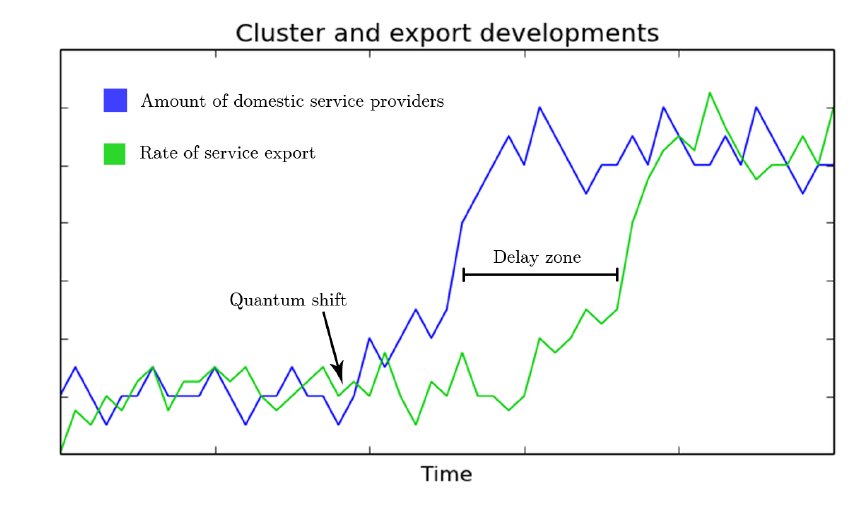
Figure 4. A theoretical relationship between a domestic cluster development and service exports. The delay zone shows a period between the cluster development and service